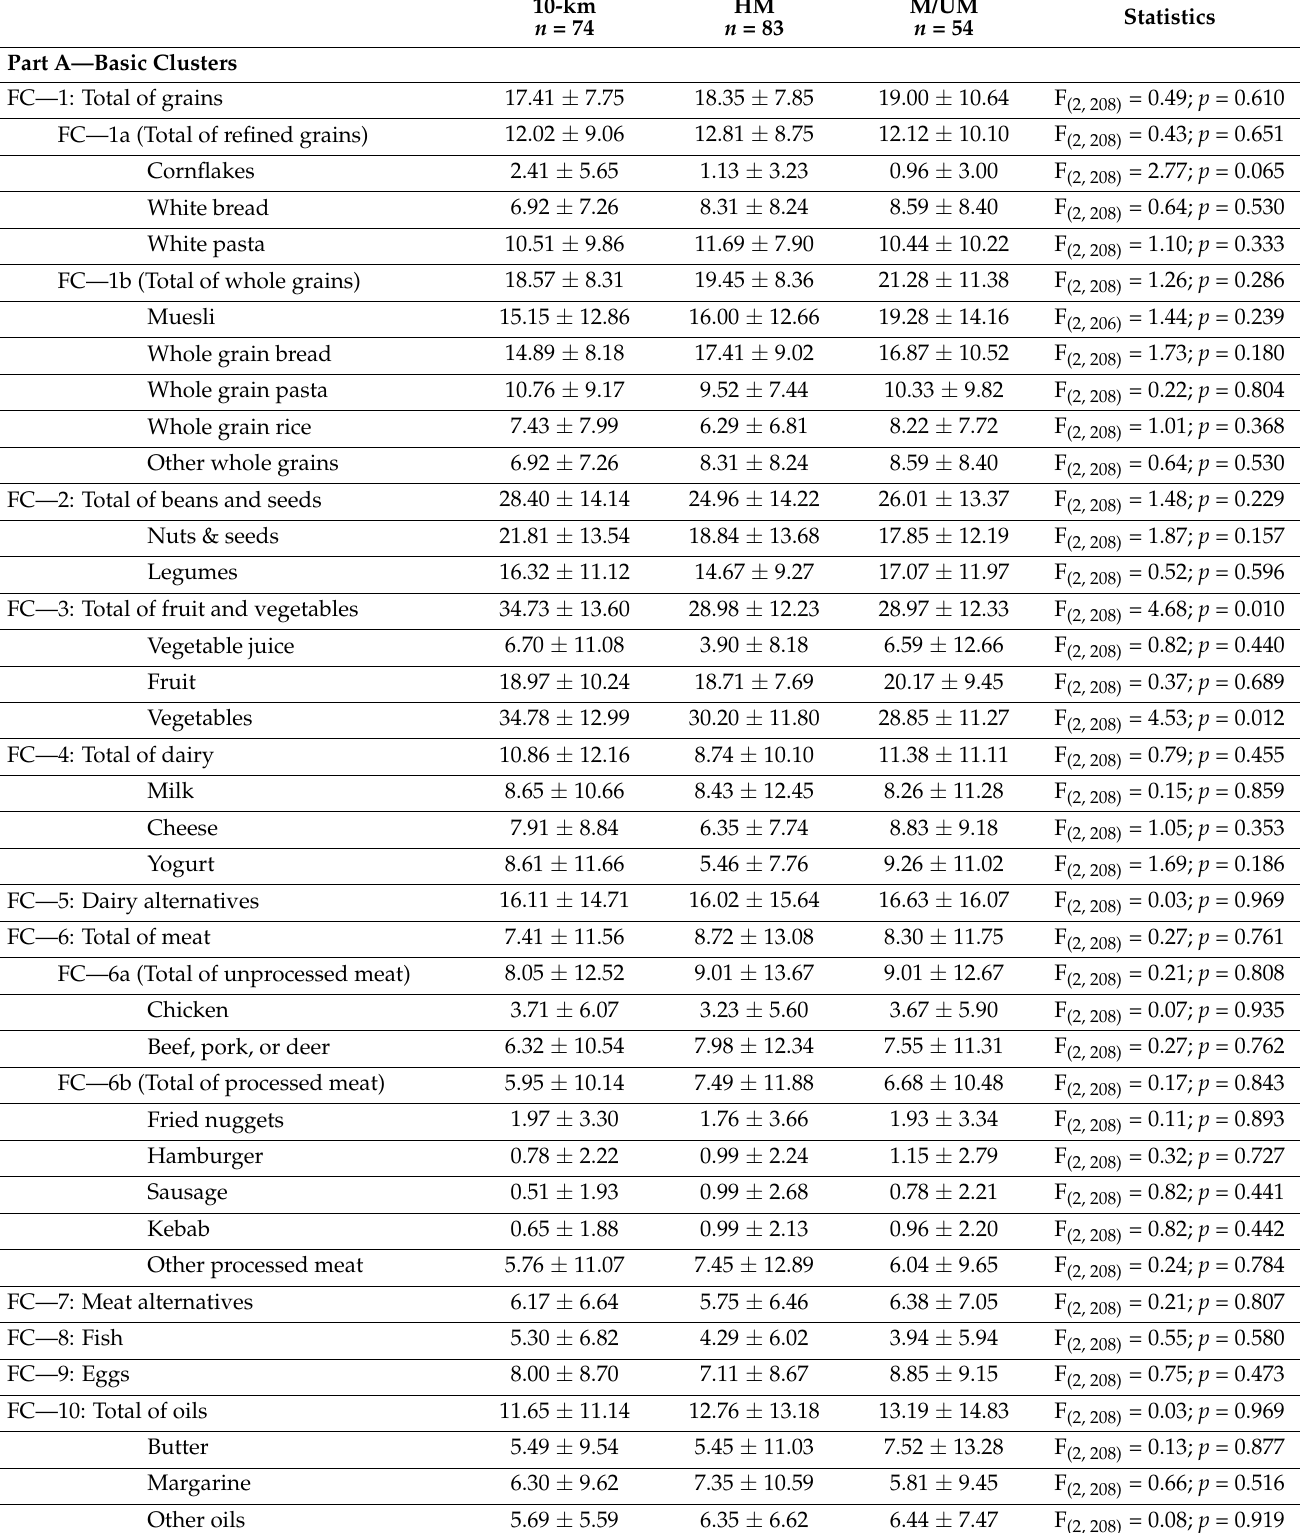
Table 3. Differences between 10-km, HM, and M/UM runners in food frequency clusters and items. 10-km n =